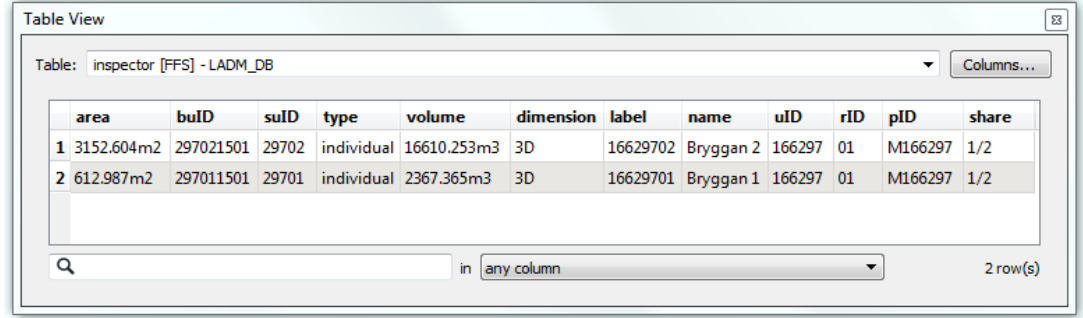
Figure 12. Cadastral information stored in LADM database.